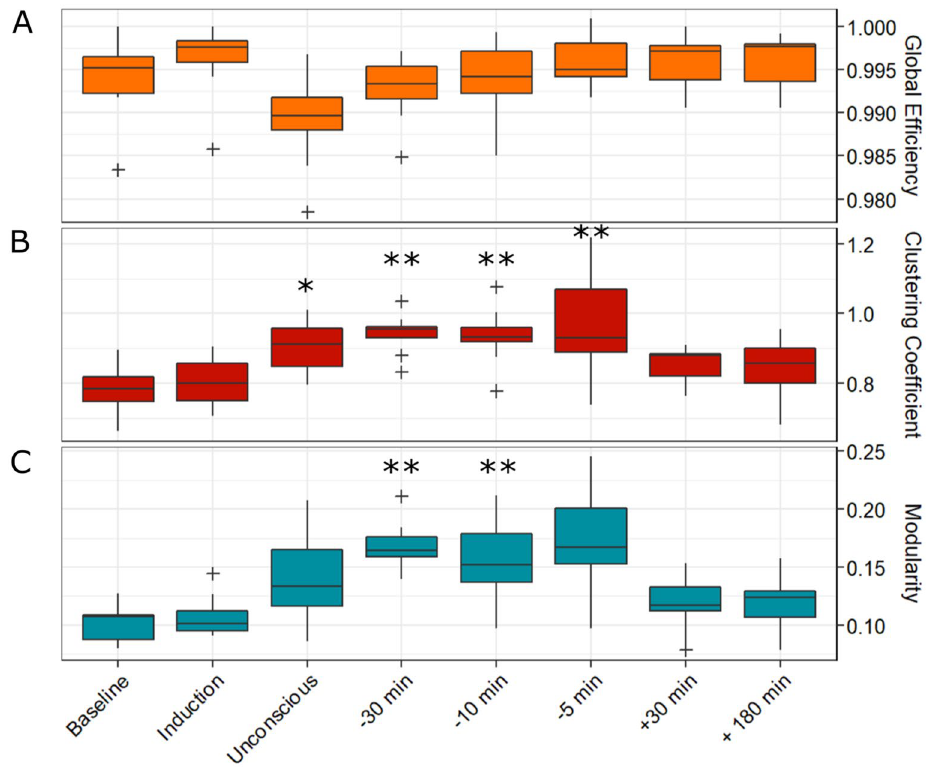
Figure 5. Global brain network properties across the experimental period. The functional brain network of each participant was constructed using a binarized wPLI matrix. From this network, we calculated global graph theoretical network properties, including global efficiency ( A ), clustering coefficient ( B ), binary small-worldness and modularity ( C ), across the eight analysis epochs. Changes in binary small-worldness were driven by changes in the clustering coefficient; this metric was therefore also significantly increased from Baseline at Unsconsious, 30-, 10-, and 5-min pre-recovery of consciousness epochs (not plotted due to redundancy). Boxes represent the interquartile range, with the lower and upper limit of boxes indicating 1st and 3rd quartiles, respectively. The median is marked by the black horizontal line inside the boxes. The whiskers outside the boxes extend to the lowest and highest observations that are not outliers, while outliers are marked by a cross, and are defined as values greater than ± 1.5 times the interquartile range. *: p < 0.05; **: p <